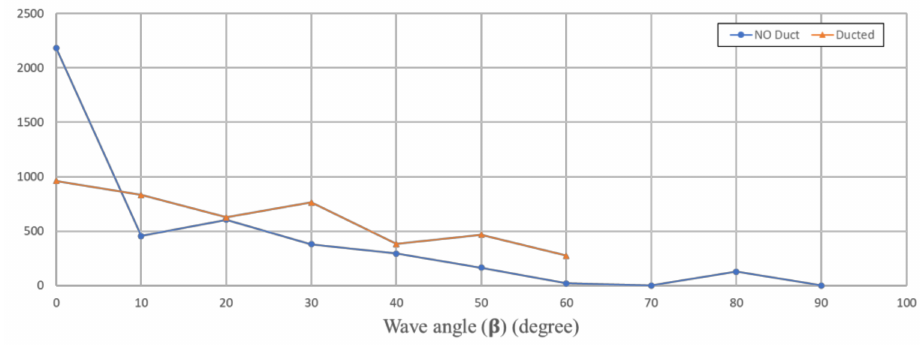
Figure 17. The pressure measured (in Pascal) of each wave angle ( β ) for the no duct case (blue circle) and the ducted case (orange